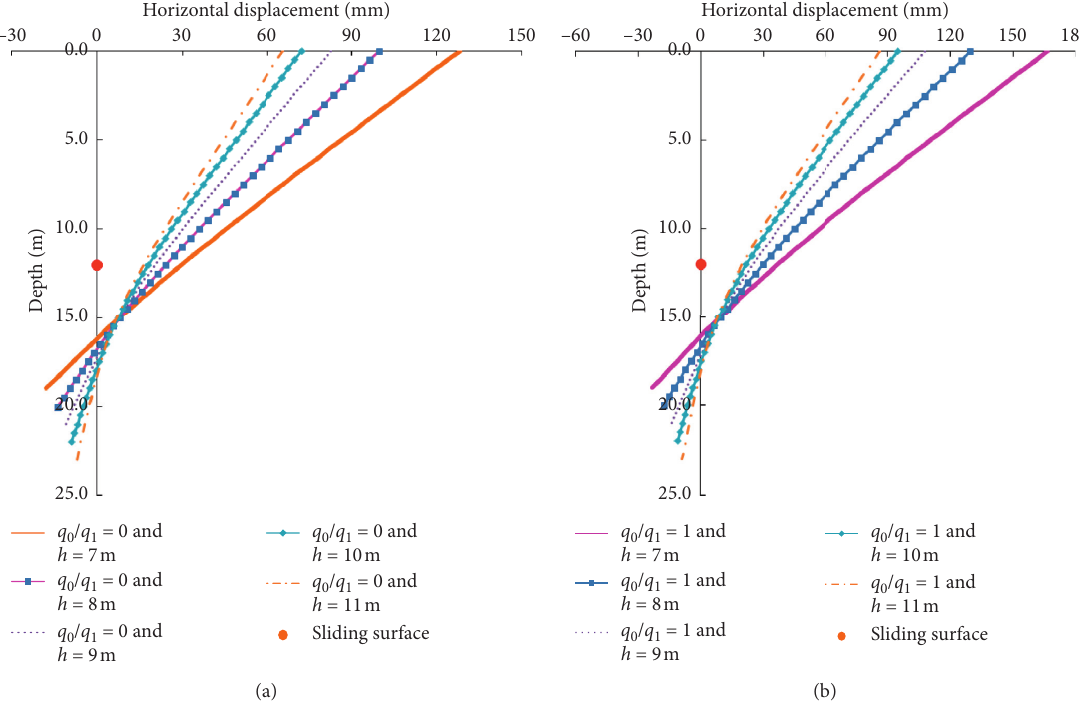
Figure 11: Calculated values of horizontal displacement for piles of various embedded lengths with different values of q 0/ q displacement under q 0/ q 1 � 0 .(b) Horizontal displacement under q 0/ q 1 �